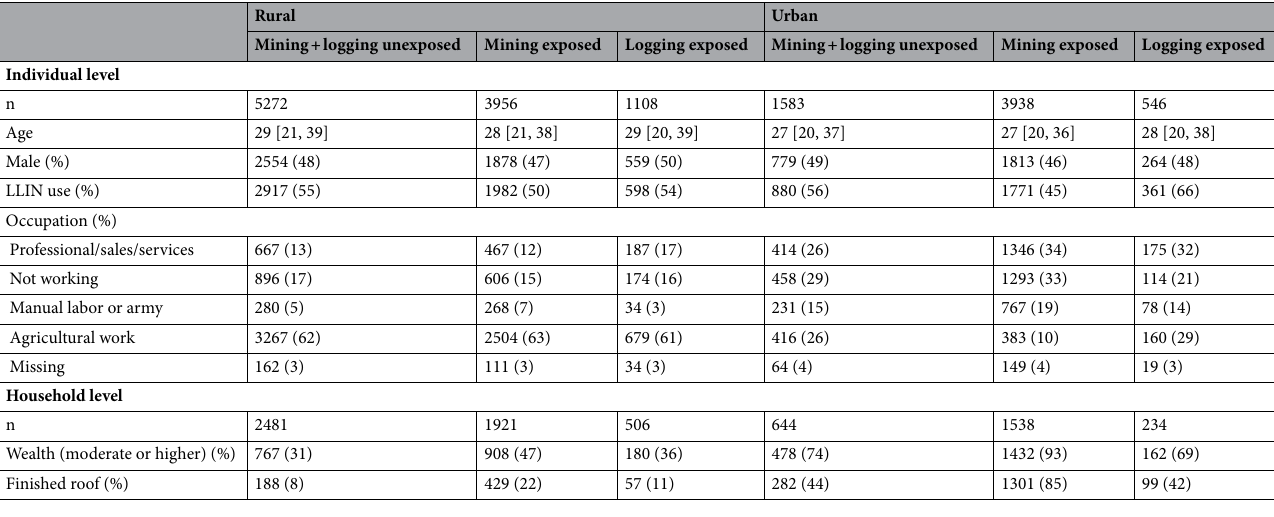
Table 2. Distributions of malaria risk factors for individuals and households residing in mining exposed, logging exposed, and doubly unexposed clusters, stratified by urban/rural status. Data are n (%) or median [IQR]. LLIN long-lasting insecticidal net.